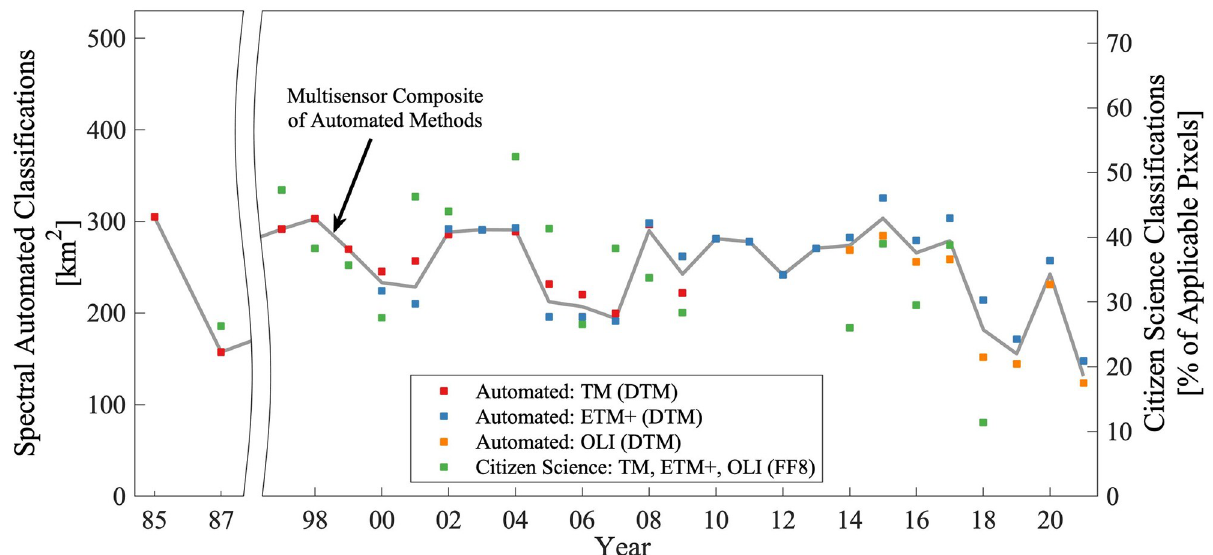
Fig 5. Timeseries of kelp canopy extent for the combined FLK region. Annual mean total canopy area within the FLK region is shown for DTM data products using TM (red), ETM+ (blue), and OLI (yellow) individual sensors, as well as a multisensor composite (gray line). FF8 data products are scaled to a separate y-axis based on the percentage of applicable pixels observed in an individual year, due to spatial patchiness in the FF8 coverage through time, and are presented as a multisensor composite (green). DTM observations in 1985 only include the western portion of FLK. Yearly intervals correspond to July of the preceding calendar year through June of the listed calendar